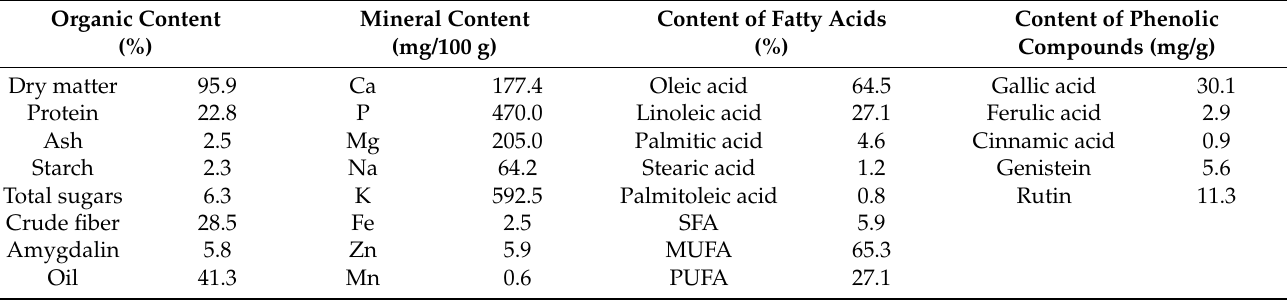
Table 1. Content of nutrients and bioactive compounds of apricot